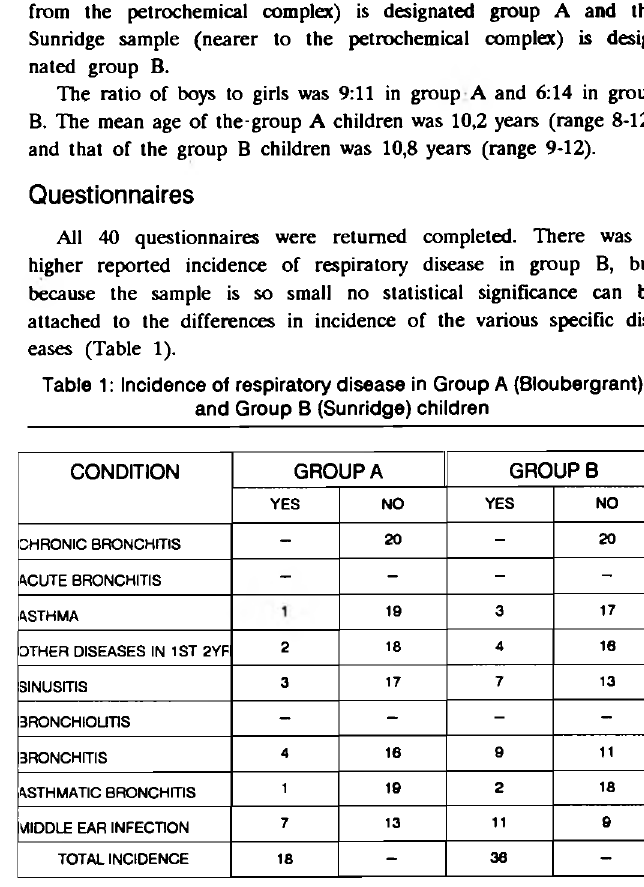
Table 1: Incidence of respiratory disease in Group A (Bloubergrant) and Group B (Sunridge) children